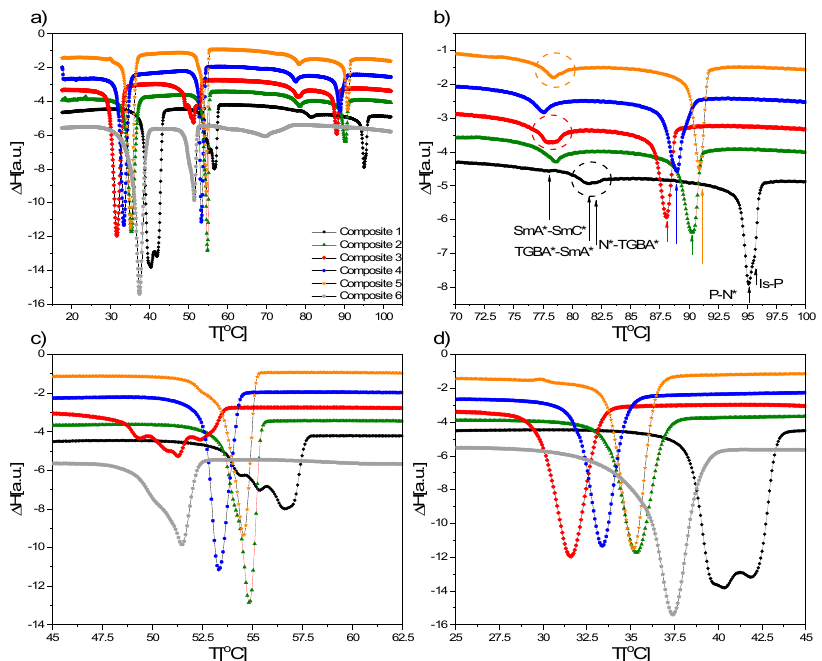
Figure 5. ( a ) DSC curves registered during cooling at a rate of 10 °C/min for Composites 1-6 and ( b ) extended temperature ranges of 100.0–70.0 °C, ( c ) 62.5–45.0 °C and ( d ) 45.0–25.0 °C.